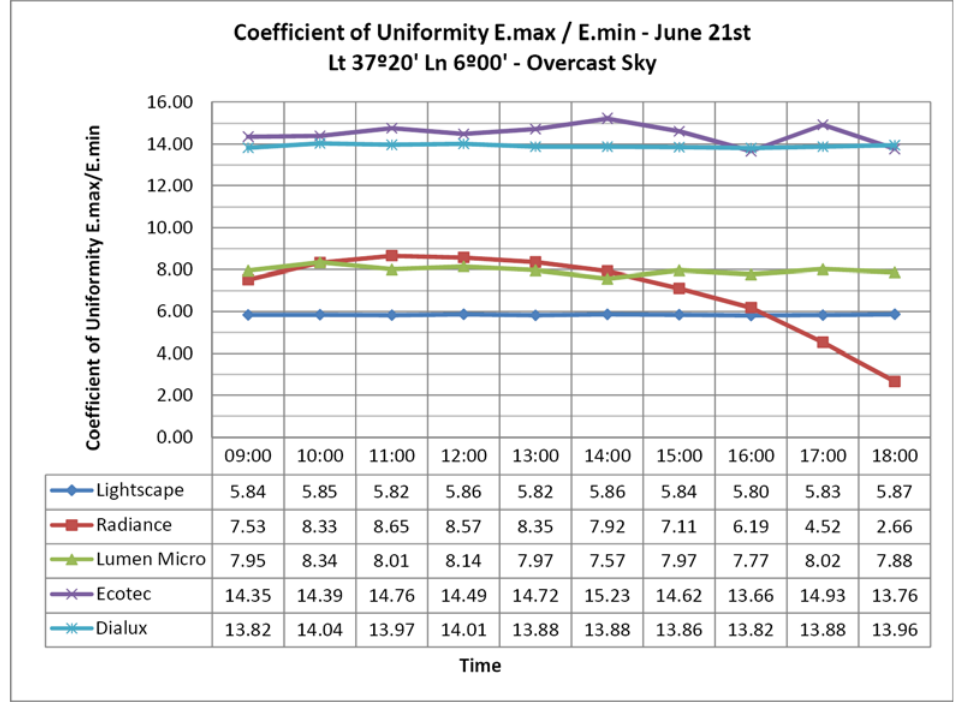
Figure 4. Coefficients of Uniformity (Max/Min illuminance levels). From 9:00 to 18:00 on June 21st, overcast